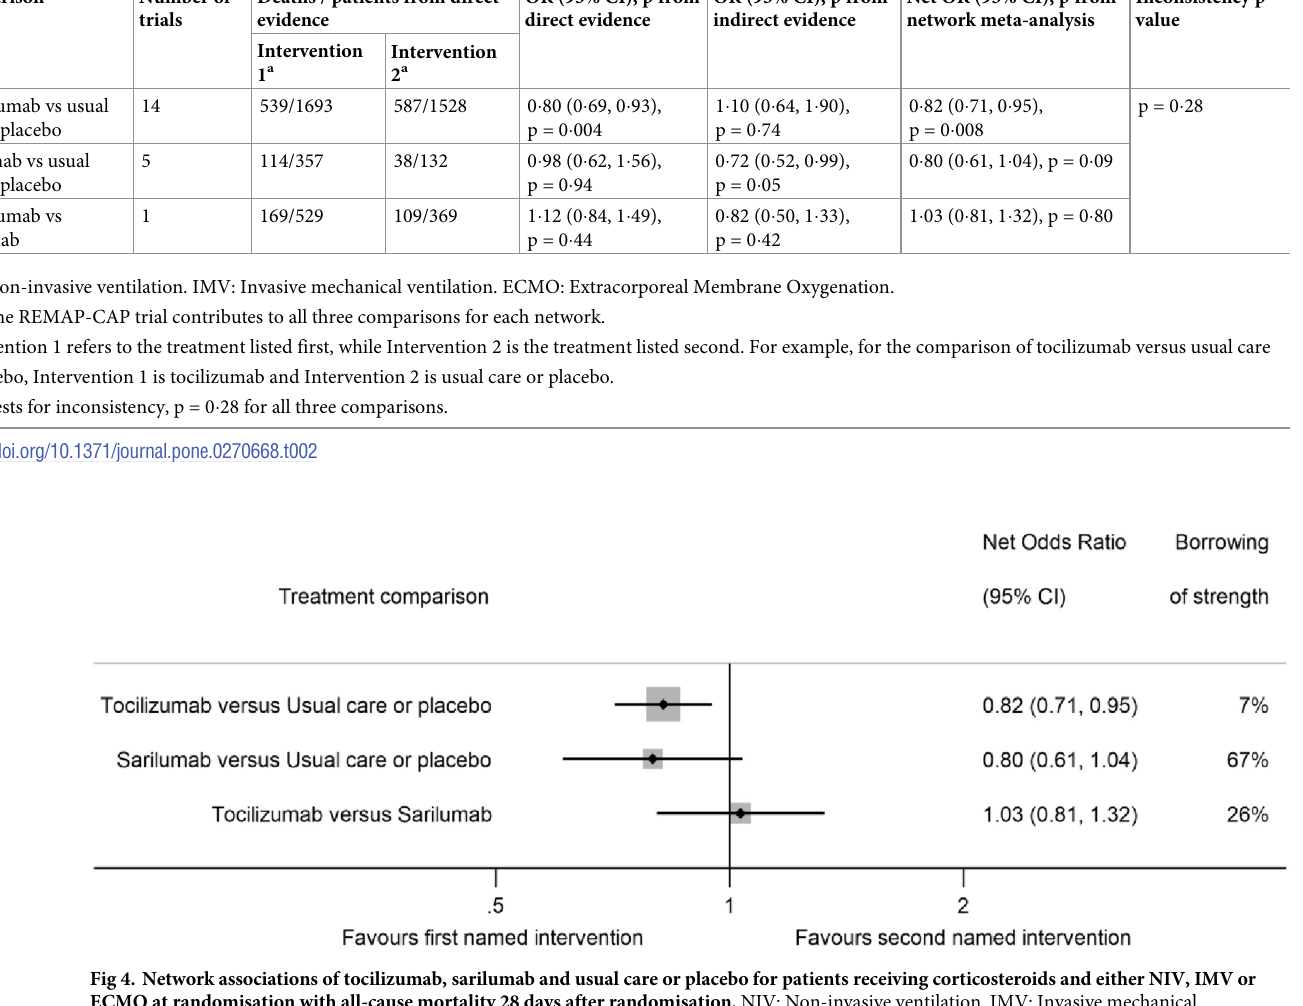
Table 3. Ranking of interventions (% probability) and SUCRA values for all-cause mortality 28 days after randomisation. Rank Sarilumab